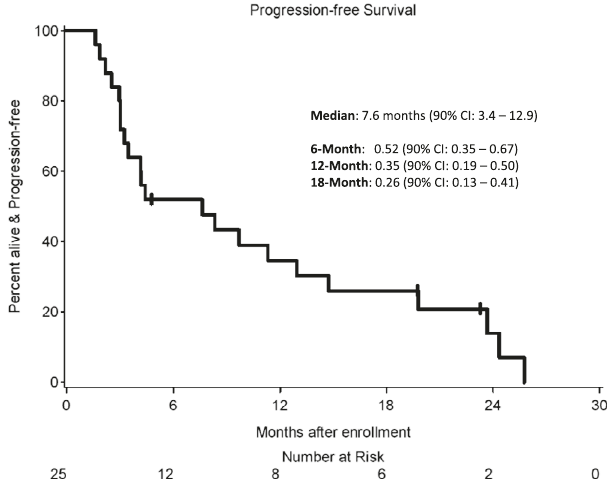
Fig. 1 Kaplan – Meier curve for progression-free survival. Kaplan – Meier estimates of PFS are shown. There were 22 PFS events among 25 patients. The median PFS was 7.6 months (90% CI: 3.4 –